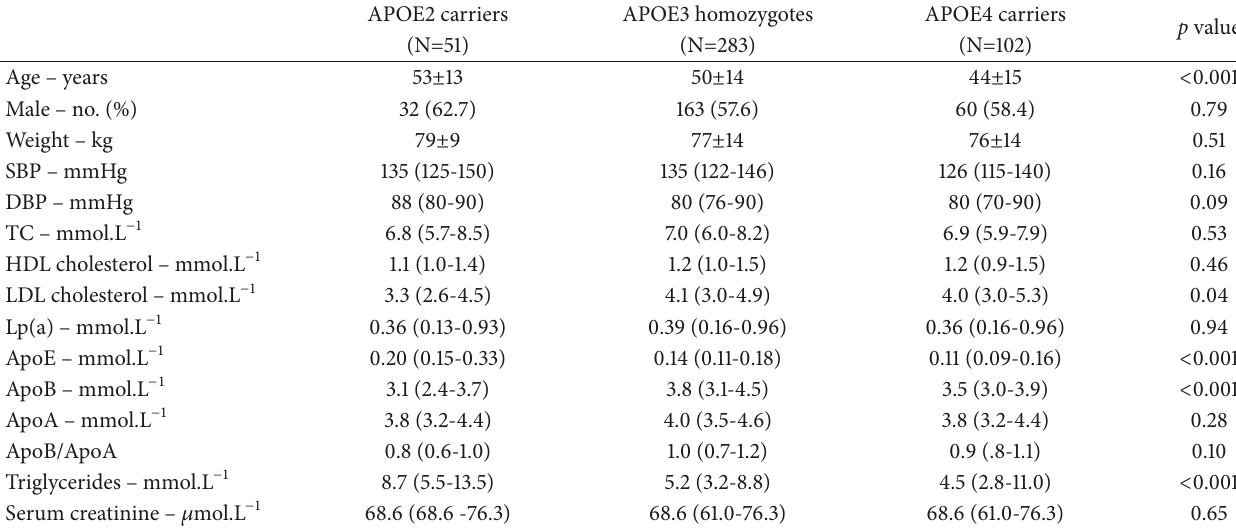
Figure 2: Kaplan–Meier estimates of (a) CV mortality, MI and stroke and (b) T2DM incidence in the different APOE genotypes. CV: cardiovascular; MI: myocardial infarction; T2DM: diabetes mellitus; APOE: apolipoprotein E. Table 2: Baseline characteristics of the 436 patients with different APOE